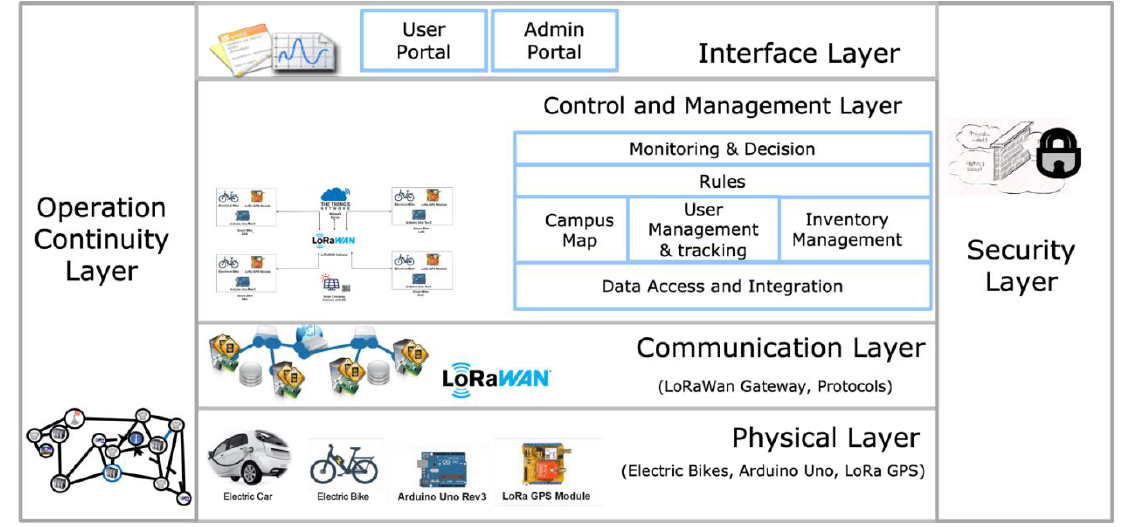
Figure 2. EV shared mobility reference model.